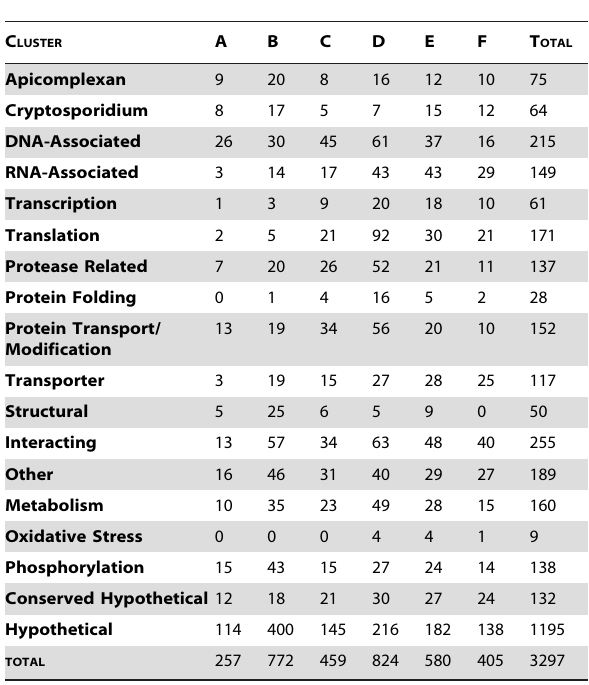
Table 3. Functional Categories Distribution across 2-24 hr.